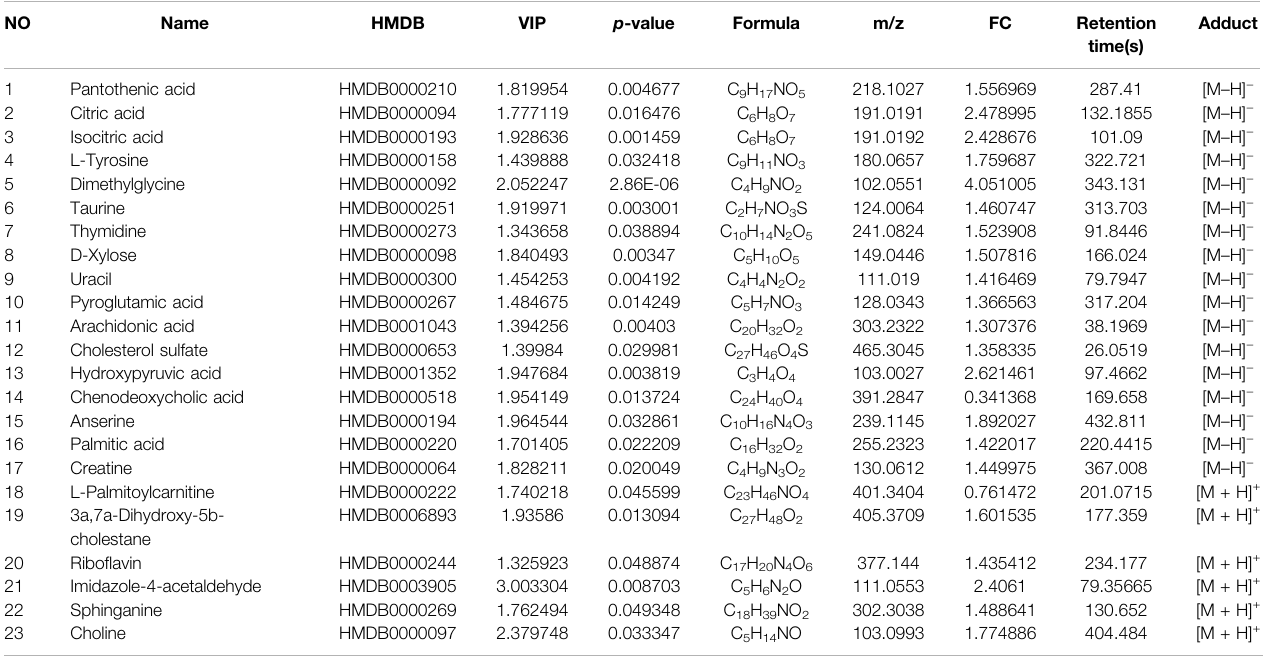
TABLE 1 | Differential metabolites identi fi cation of serum.